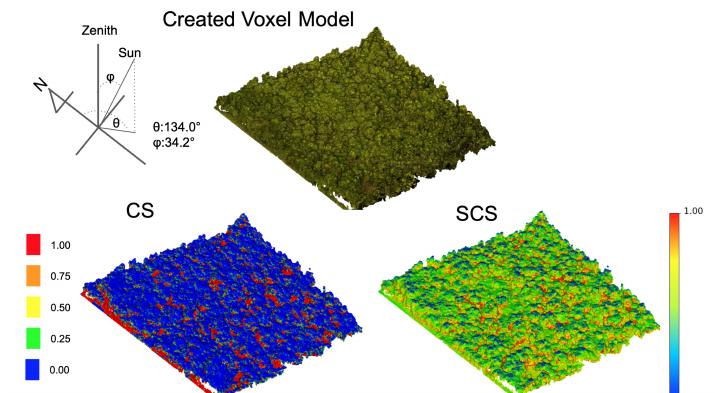
Figure 6. Created voxel model of the study forest and spatial distribution of CS and SCS. CS was calculated based on the position of the sun when Sentinel-2 observed. The azimuth and zenith angle are 134.0 ◦ and 34.2 ◦ , respectively. Spatial distribution of CS, the most frequent value is 1.0, followed by 0.0, which can be visually seen. On the other hand, SCS was around 0.5 for most voxels.